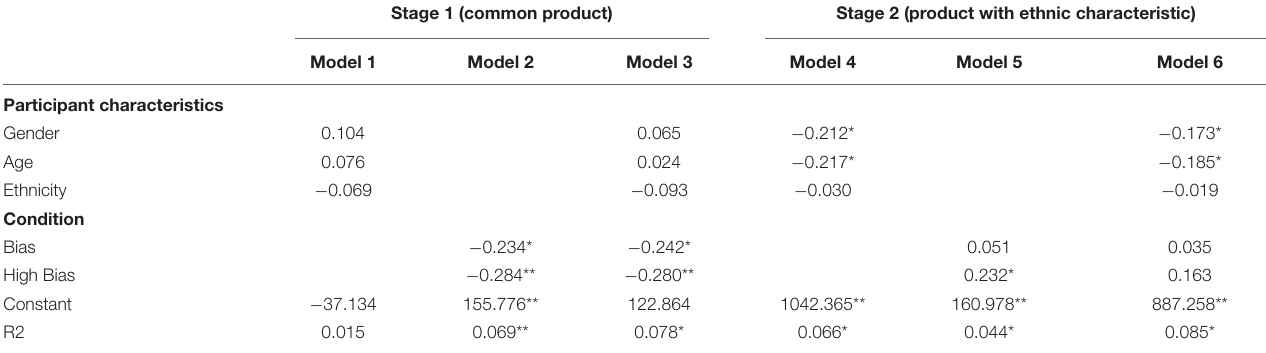
TABLE 2 | The regression results of OLS estimates of recommended